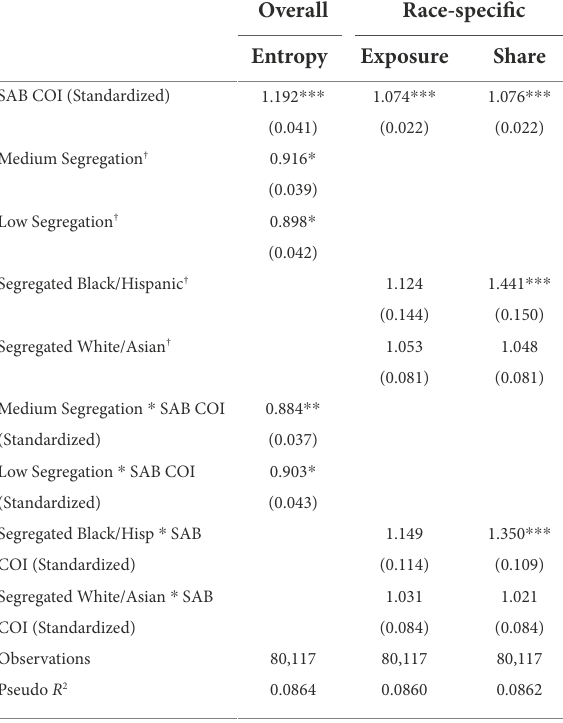
All variables include student characteristics as listed in Model 1 of Table 4. Robust standard errors in parentheses.